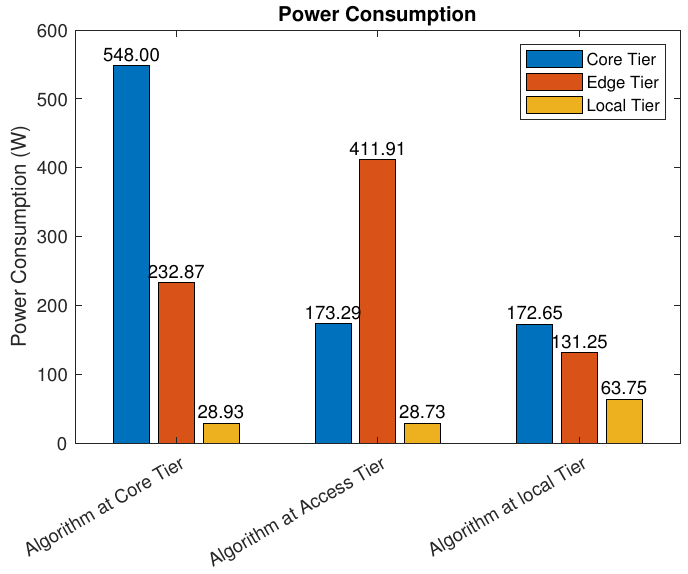
Figure 6. Power consumption: without the blockchain. With the blockchain: Figure 7 depicts the power consumption of three IoT models when blockchain pre-processing was used. When the analysis algorithm was placed at the core tier (data center), the total power consumption was 895.87 W. The core tier power consumption was 612.00 W, the access tier consumption 251.94 W, and local tier consump- tion 31.93 W. When the analysis algorithm was placed at the access tier (MEC server), the total power consumption was 695.28 W, consisting of the core tier power consumption of 197.24 W, the access tier consumption of 465.91 W, and local tier consumption of 32.13